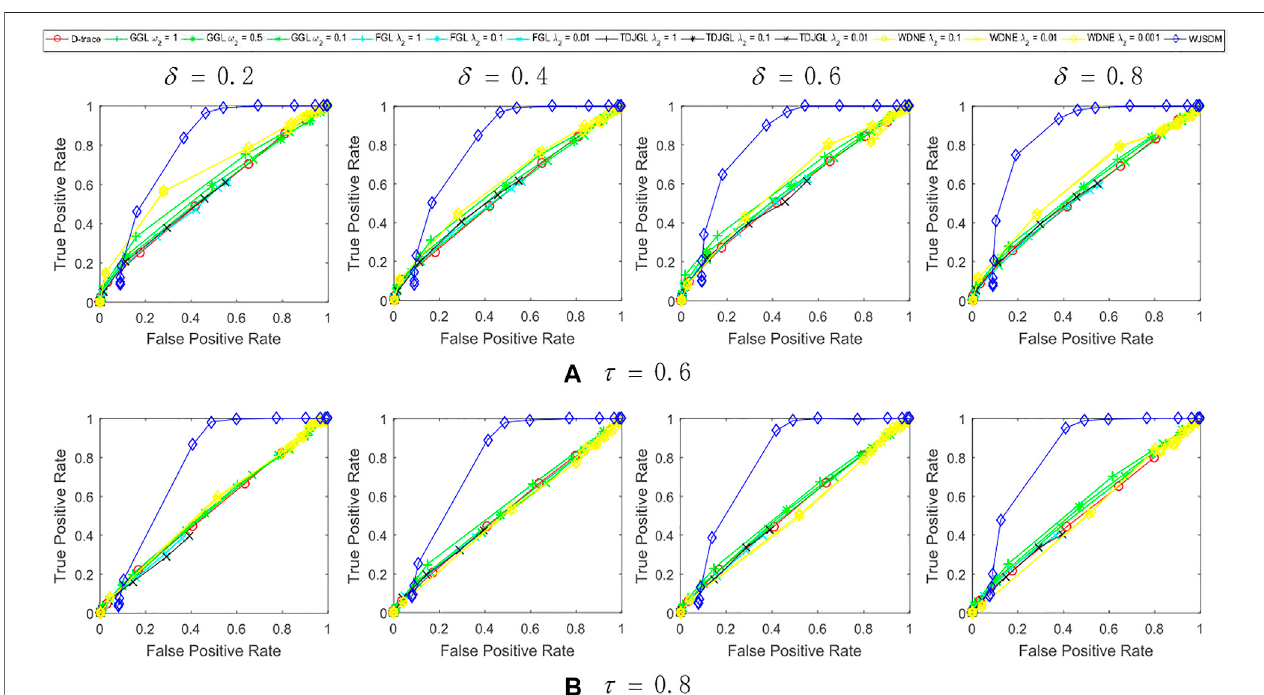
FIGURE2| PerformanceofWJSDM,D-trace,GGL,FGL,TDJGLandWDNEwith p (cid:1) 100, K (cid:1) 3, n (cid:1) 100andmissingrate (A) τ (cid:1) 0.6, (B) τ (cid:1) 0.8.Withineachplot, eachlinepresentstheperformanceofamethodwiththevalueof λ (forWJSDMandD-trace), λ 1 (forFGL,TDJGLandWDNE)or ω 1 (forGGL)varyingfora fi xedvalueof λ 2 (for FGL, TDJGL and WDNE) or ω 2 (for GGL). Each curve is obtained by averaging the performance of a method over ten random generations of data.